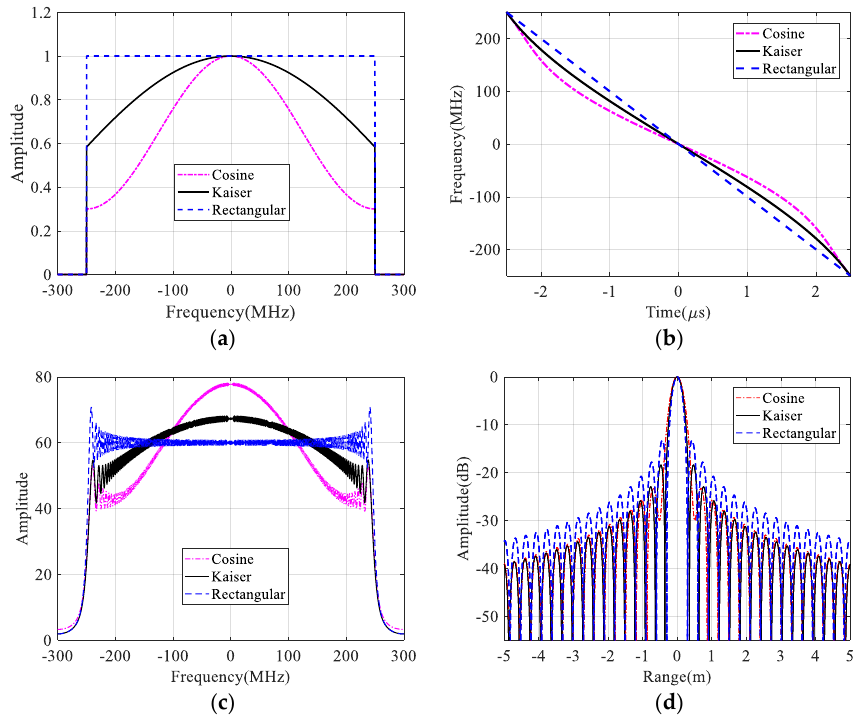
Figure 2. NLFM waveform design results with different types of window functions. ( a ) Different window functions. ( b ) Time – frequency relationships of designed waveforms. ( c ) Spectra of designed waveforms. ( d ) Pulse compression results.